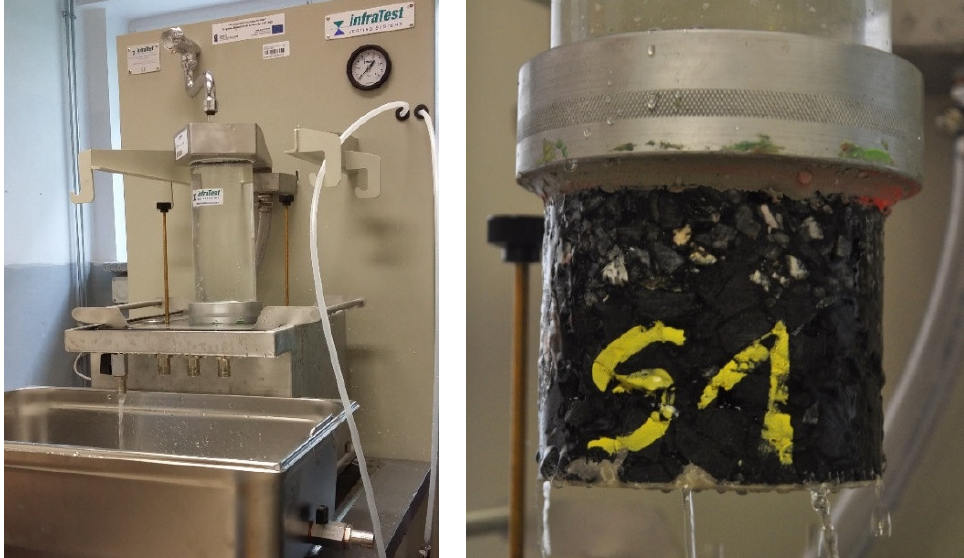
Figure 6. Vertical water permeability test.